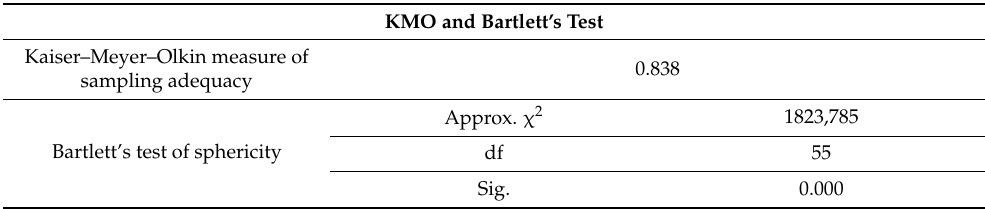
Table 2. Tests of goodness-of-fit.